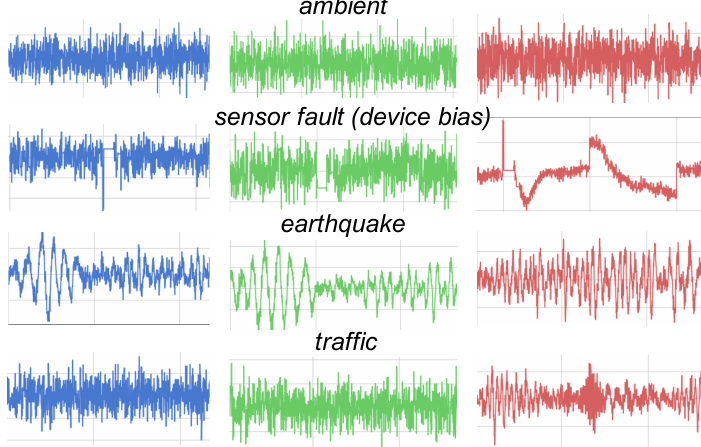
Figure 3. Typical waveforms illustrating di ff erent vibration